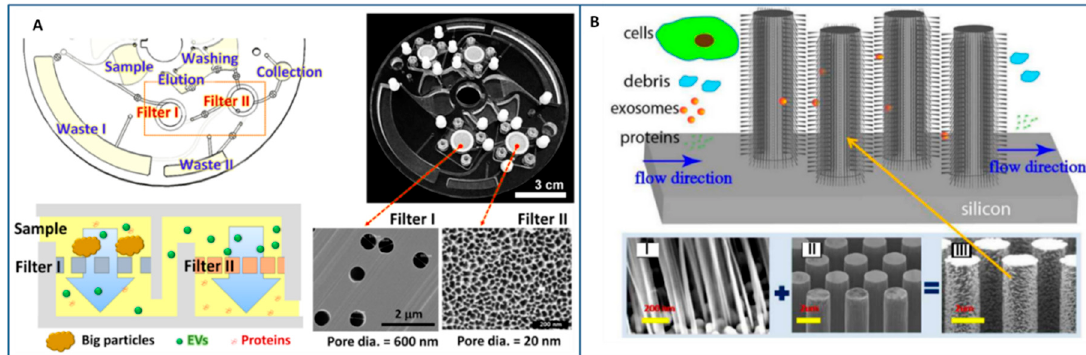
Figure 4. Size-exclusion methods for exosomes separation based on membranes and micropillars. ( A ) Photograph and schematic diagrams of the Exodisc showing its multiple functions of filtration, washing, reagents storage, and waste collection. Scheme and SEM images of the two filters (pore diameters of 600 nm and 20 nm, respectively) Reproduced with permission from reference [144], Copyright 2017 American Chemical Society; ( B ) Schematic of the trapping process of exosomes in a ciliated micropillar array and zoom of I) the porous silicon nanowire forest, II) micropillars, and III) ciliated micropillars. Reprinted with permission from reference [145] Copyright 2014 ROYAL SOCIETY OF CHEMISTRY.